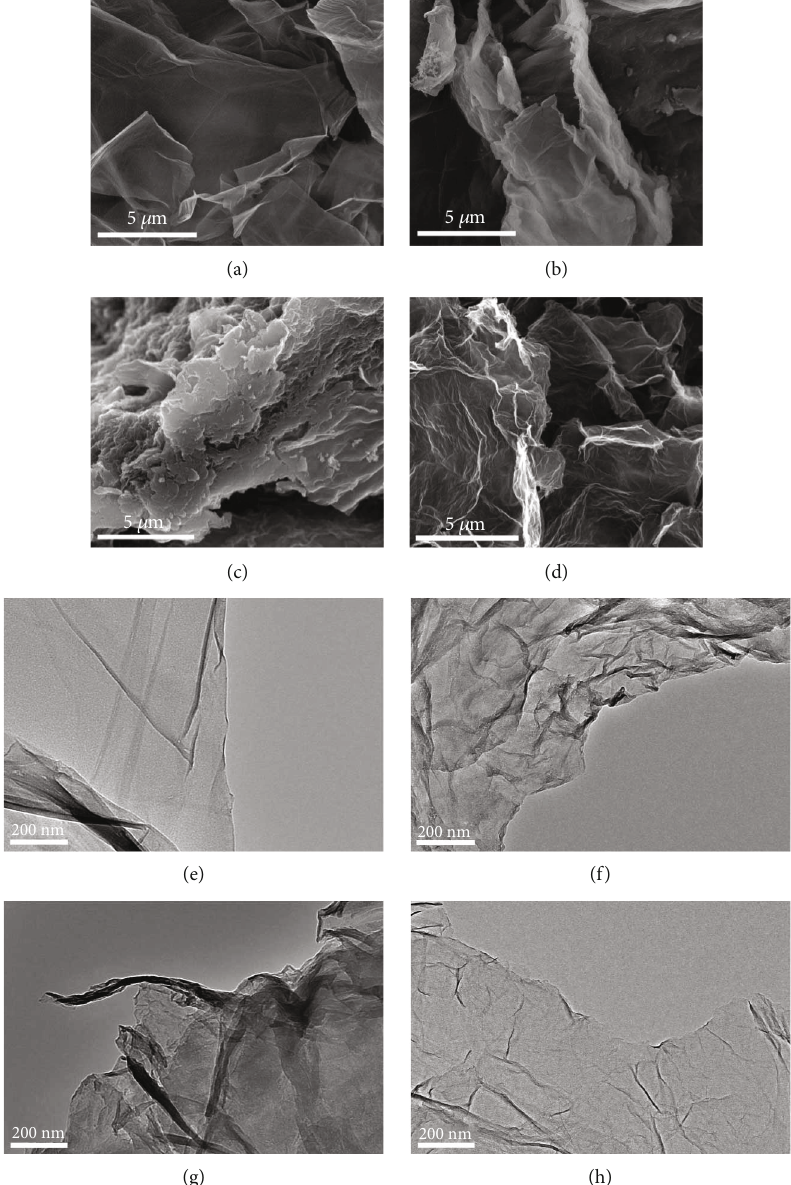
Figure 2: Scanning electron microscopy (SEM) (a – d) and transmission electron microscopy (TEM) (e – h) images of GO (a, e), RGO_1 (b, f), RGO_2 (c, g), and CG (d,